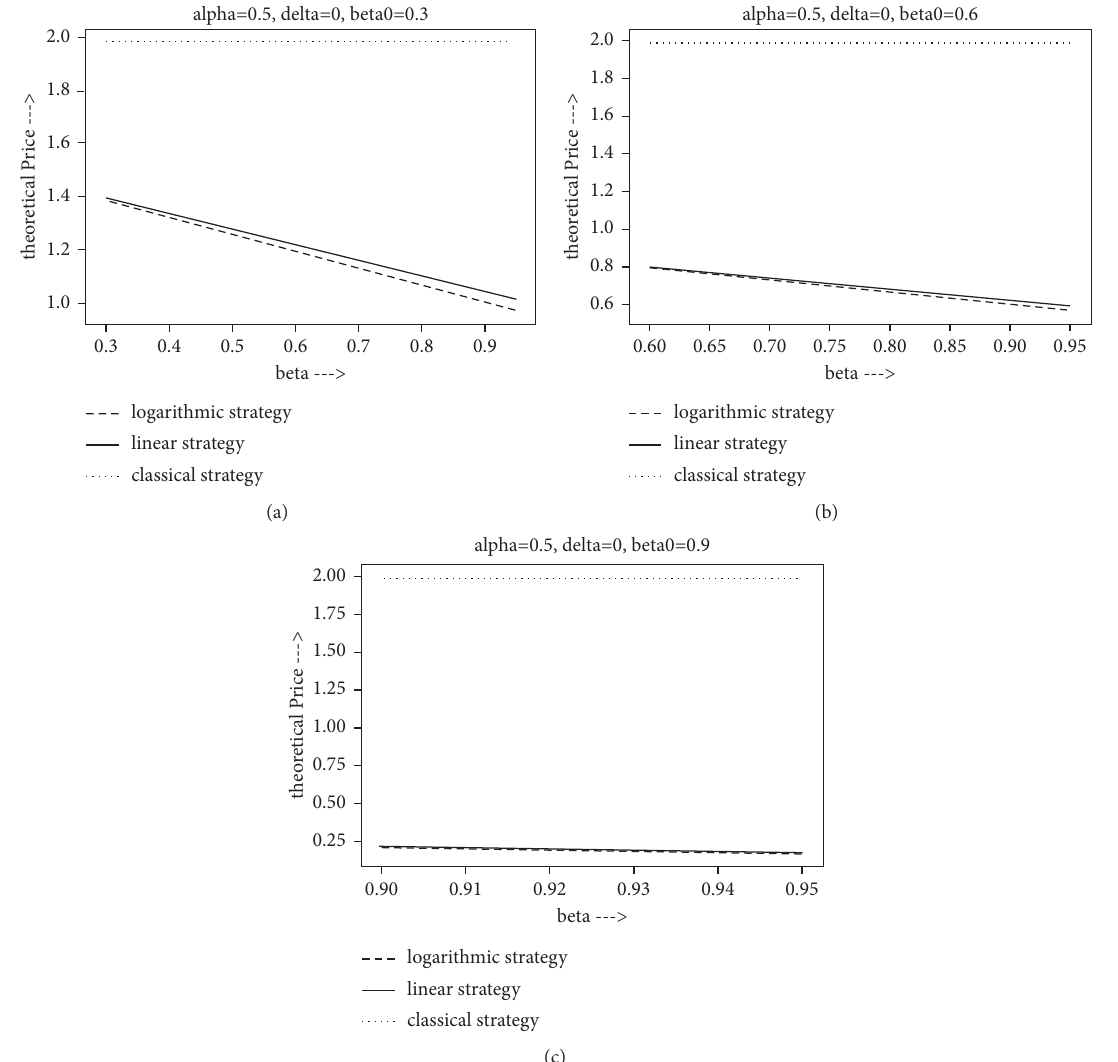
Figure 6: The theoretical price as a function of β when α � 0 . 5, δ � 0, and β